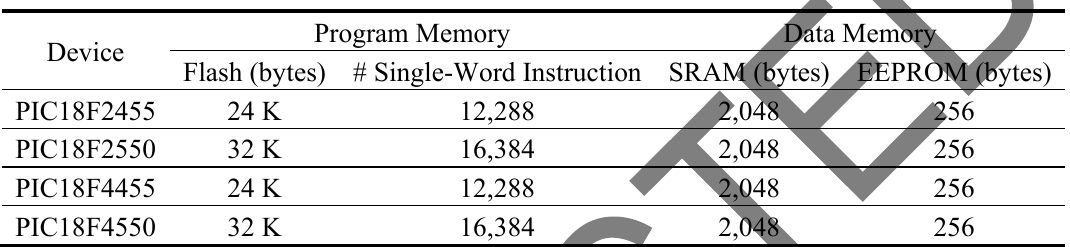
Table 3. The PIC Microcontroller PIC18F2550 Datasheet.